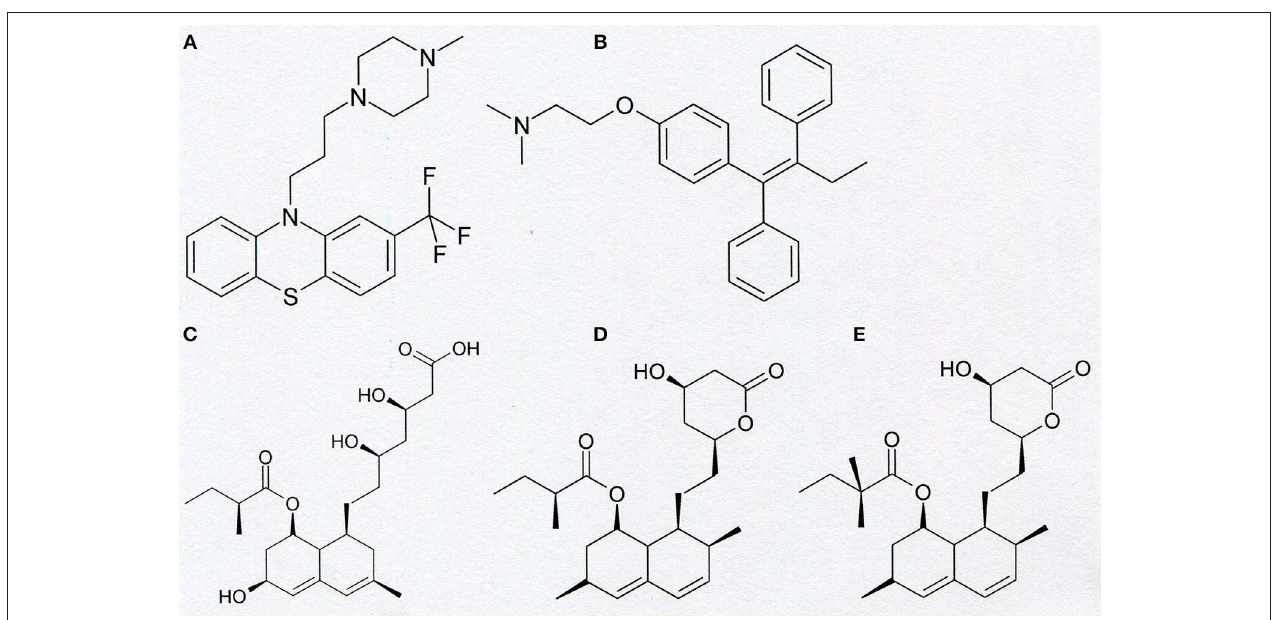
FIGURE 5 | Chemical structure of trifluoperazine (A) , tamoxifen (B) , pravastatin (C) , lovastatin (D) , and simvastatin (E) .